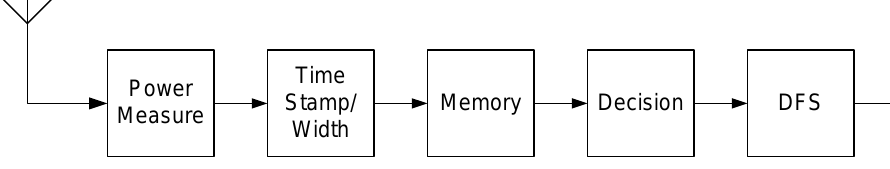
Figure 1. Block diagram of the dynamic frequency selection (DFS) algorithm.